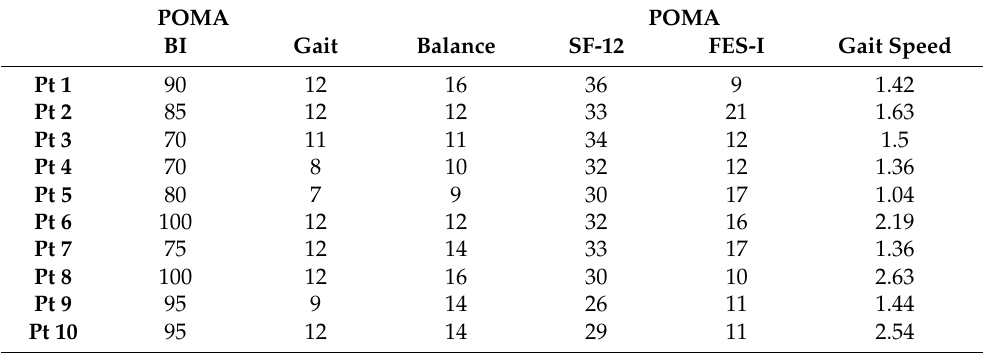
Table A2. Pre-intervention score of the BI, POMA gait and Balance, SF-12, FES-I, Gait